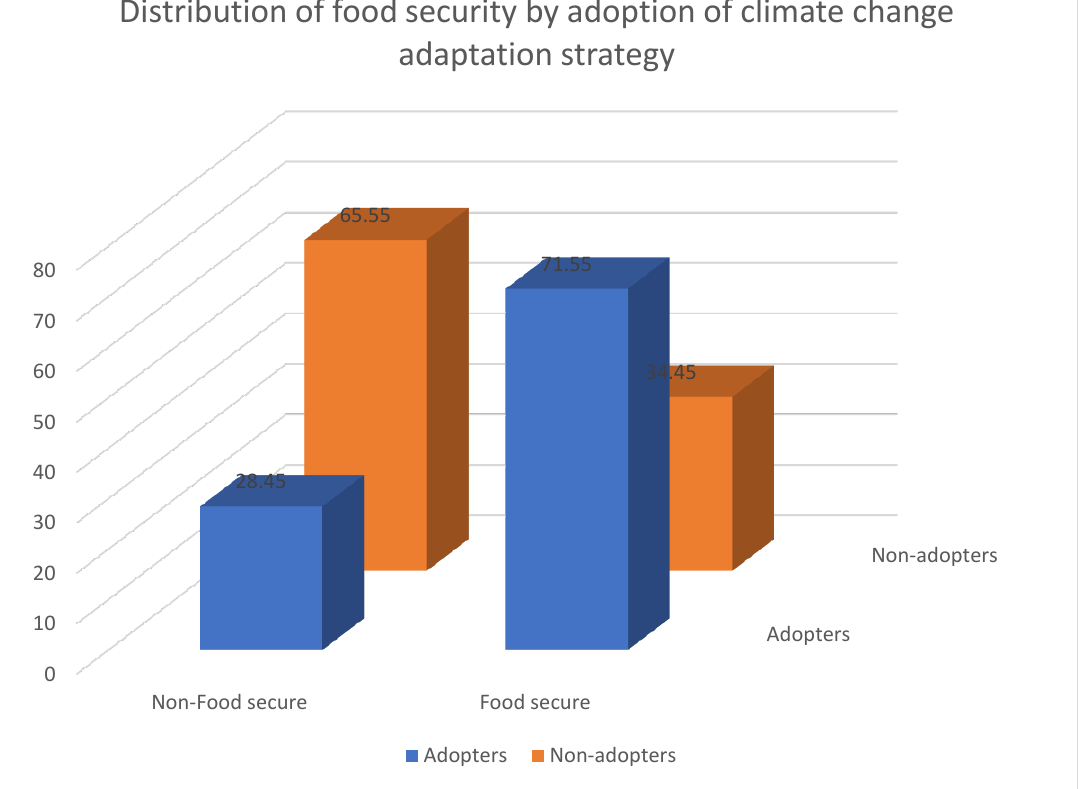
Figure 2. Household food security status in relation to adoption of climate change adaptation strategies.